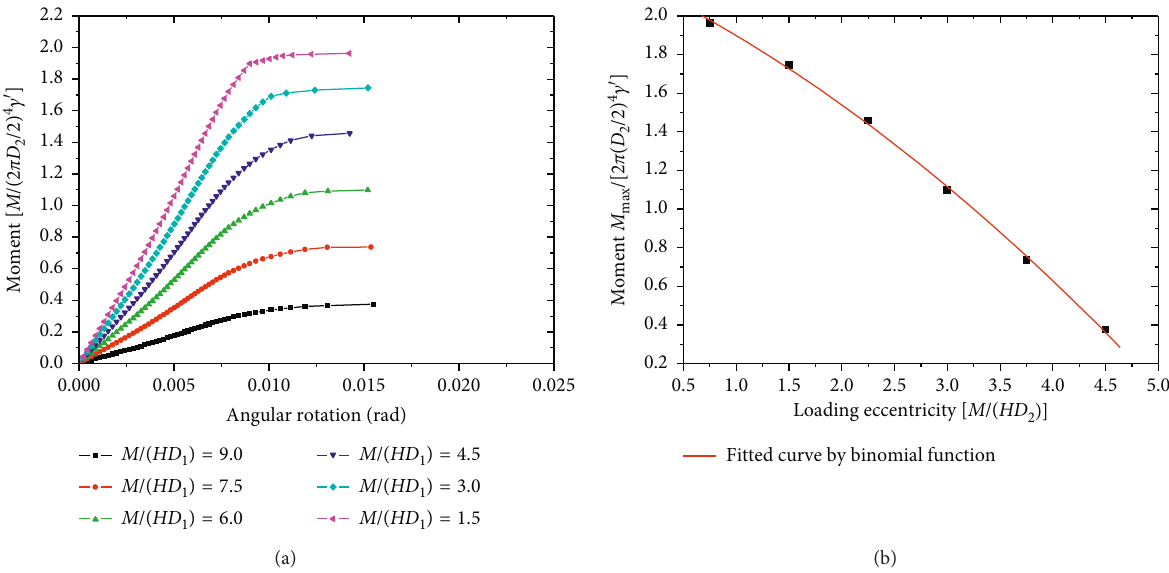
Figure 14: Moment against the rotation angle under various aspect ratios. (a) Moment against rotation angle. (b) Maximum moment against aspect ratio.